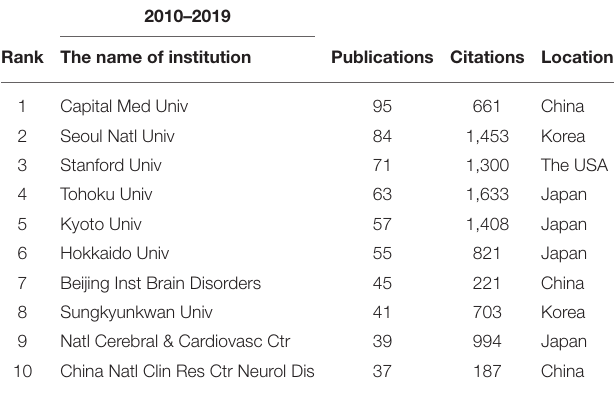
Frontiers in Neurology |